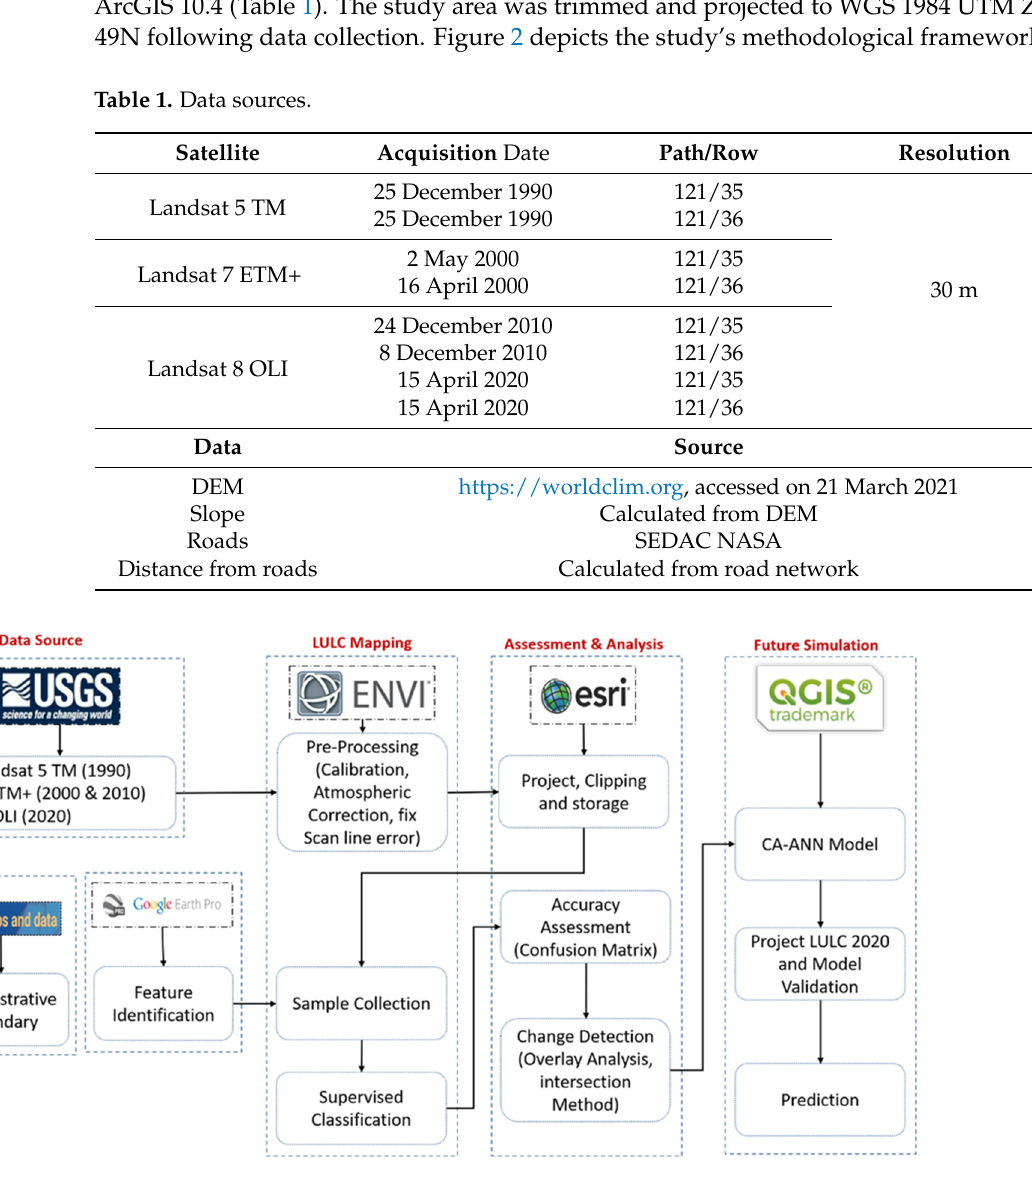
Figure 2. Methodological workflow chart.